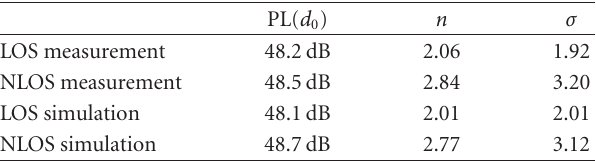
Table 2: Parameter values of measurement and simulation at 5.8GHz. PL( d 0 ) σ LOS measurement 48.2 dB LOS simulation 48.1